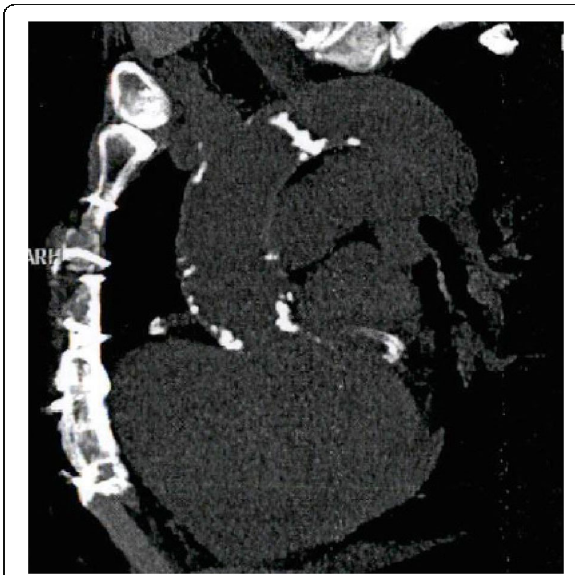
Fig. 2 Pre-discharge chest X-ray showing the implanted aortic valve, bioprosthetic mitral valve, and tricuspid valve